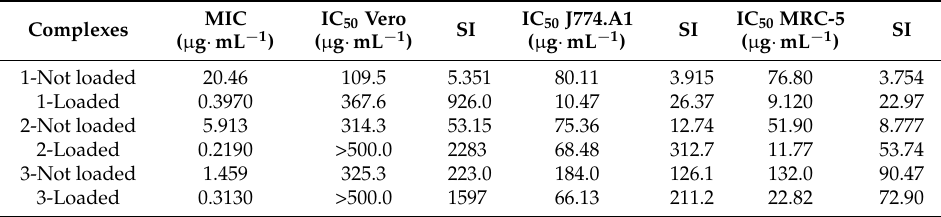
Table 4. Results of biological assays (MIC and IC 50 ) and determination of SI of the free copper(II) compounds and those loaded into the NLS against Mtb H 37